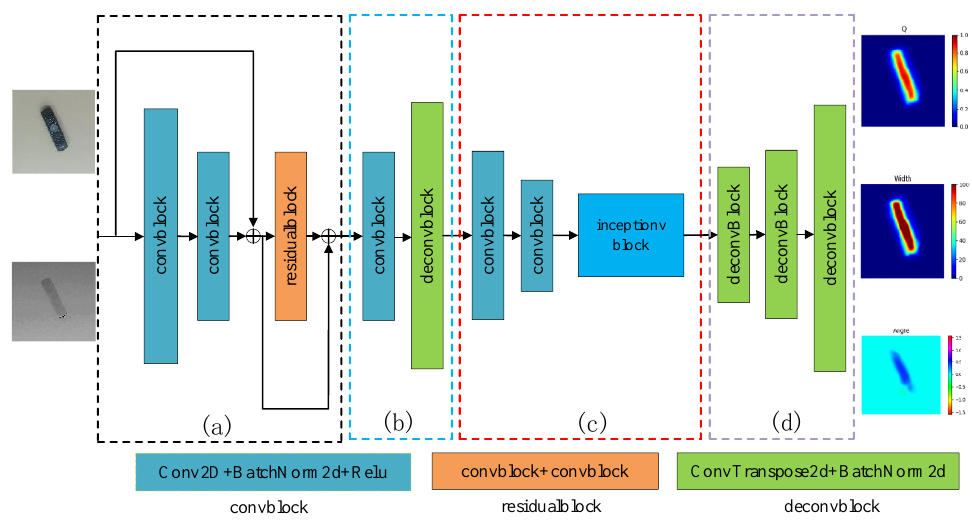
Figure 3. The structure of EDINet: ( a ) encoder module, ( b ) decoder module, ( c ) inception module, ( d ) up-sampling module.